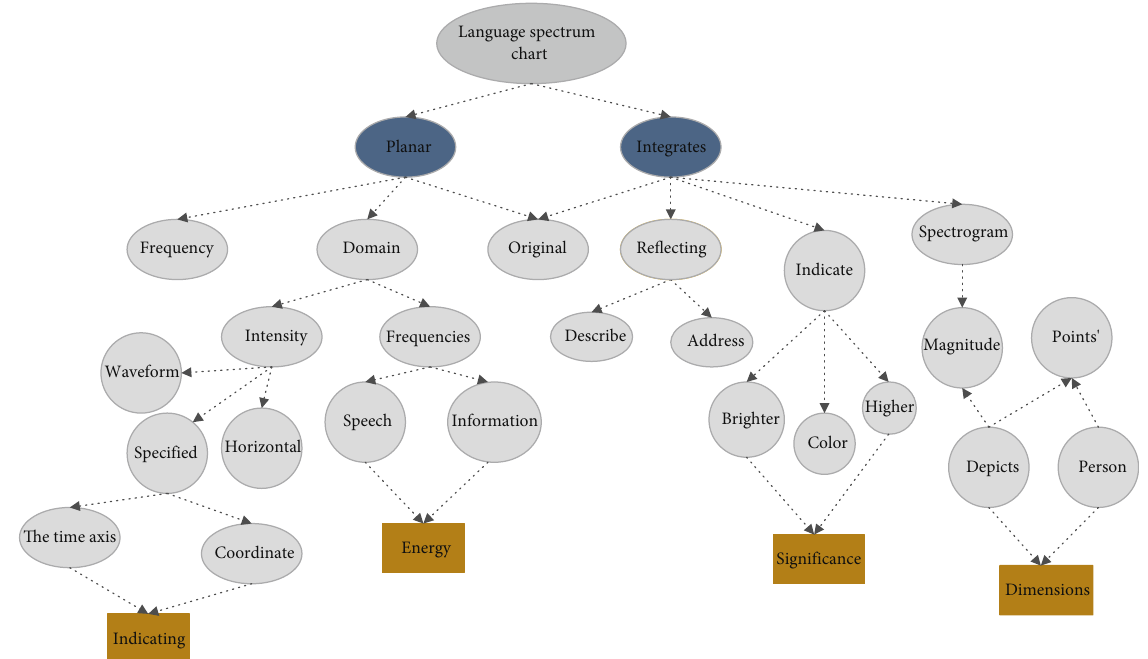
Figure 2: Flow chart of emotion recognition based on timbre-speech spectrogram.